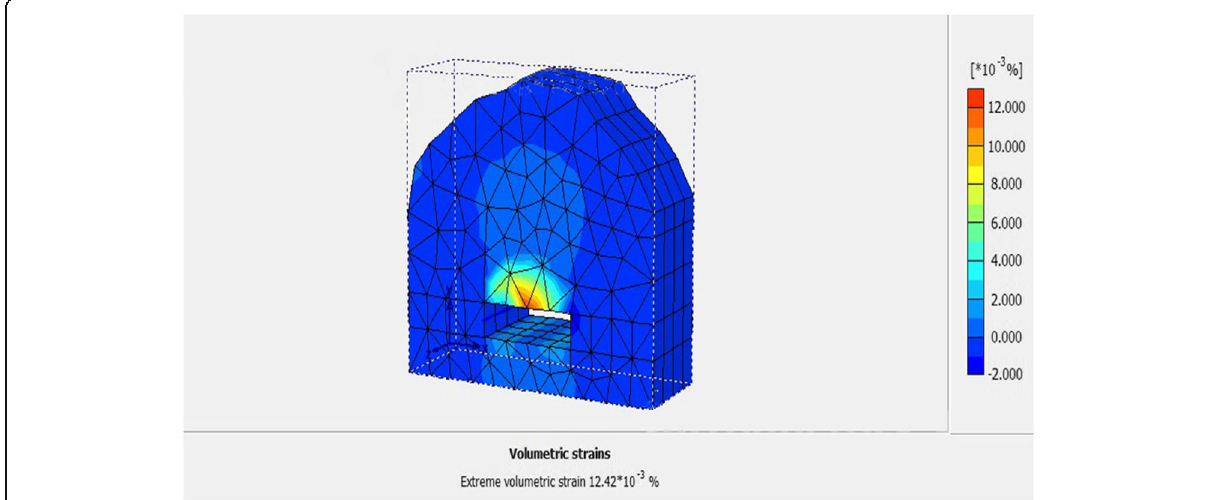
Fig. 33 Volumetric strains of the ceiling and sidewalls of northern Chamber. PLAXIS 3D